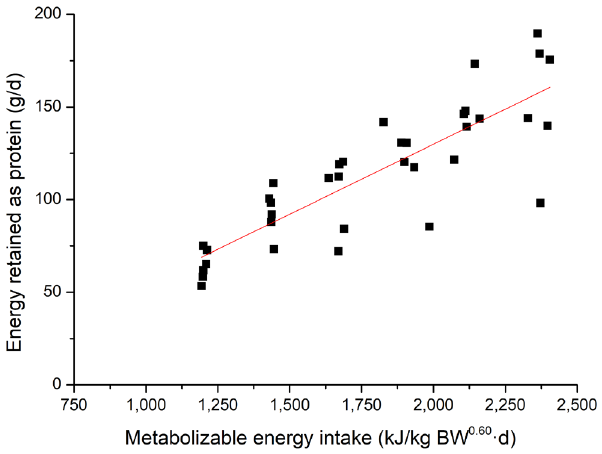
Figure 1. Linear relationship (parameters±standard error) between metabolizable energy intake (MEI) and energy retained as protein (RE